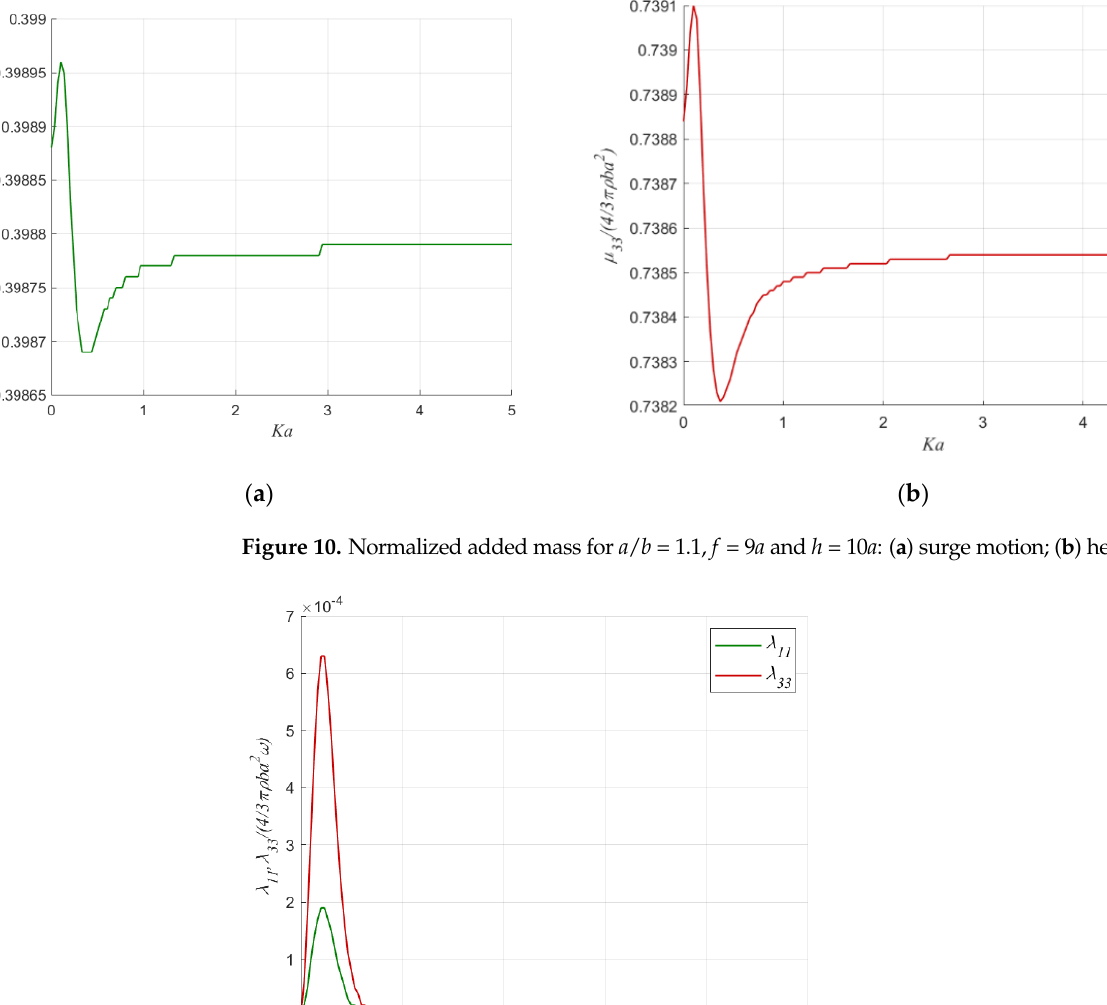
Figure 9. Normalized hydrodynamic coefficients in heave for a/b = 1.1, h = 10a: ( a ) added mass; ( b ) hydrodynamic damping.